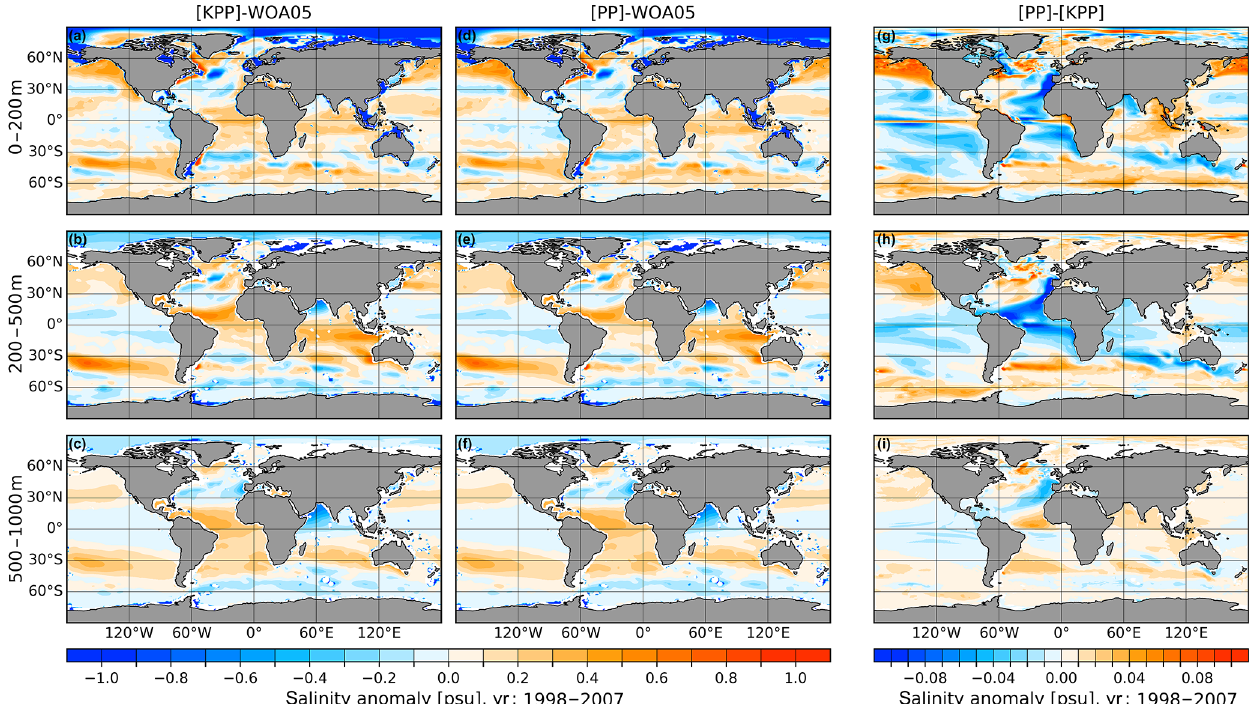
Figure 12. Same as Fig. 11 but for